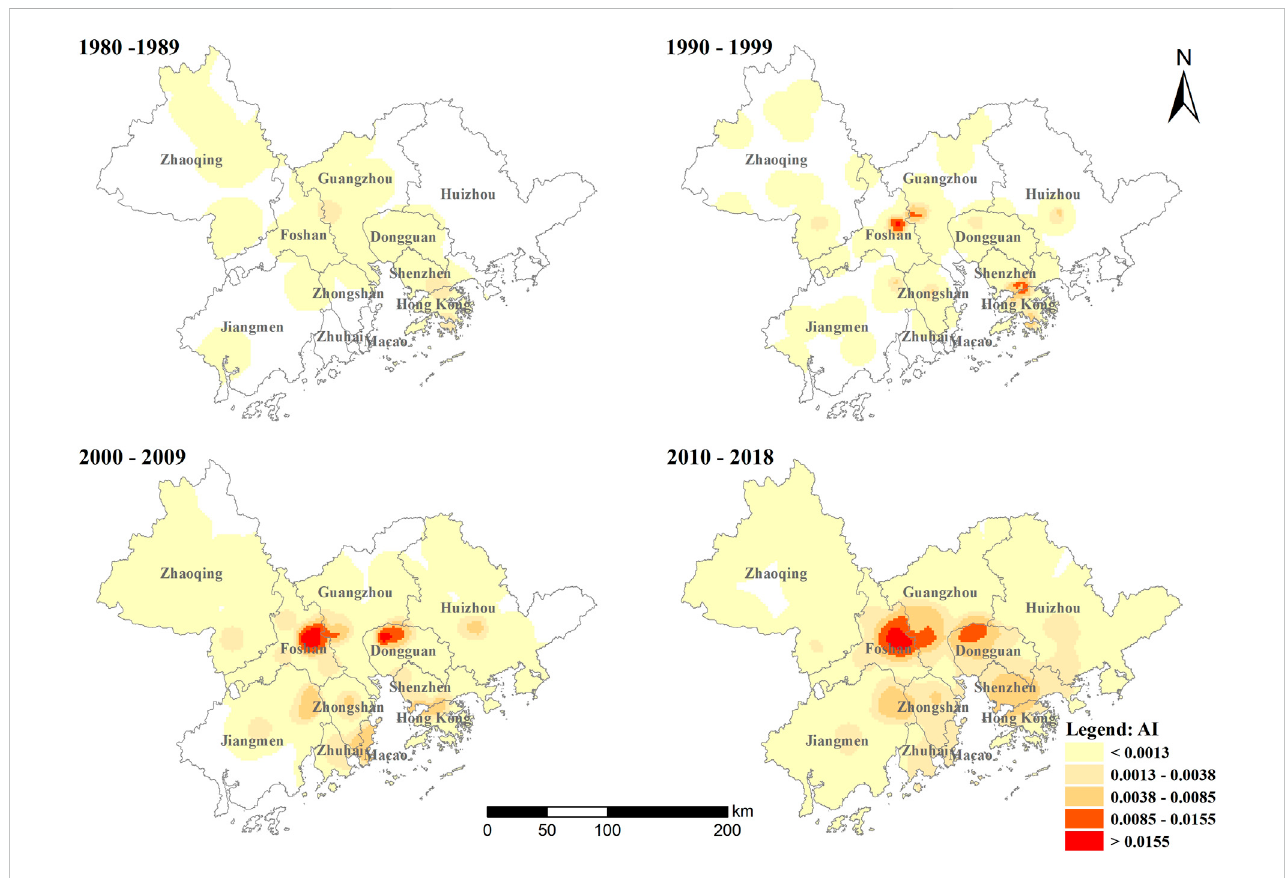
FIGURE 5 Spatial distribution of regression coef fi cients for AI during 1980 –